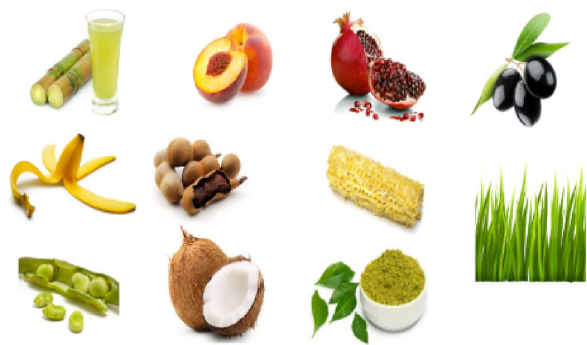
Fig. 1 Examples of food